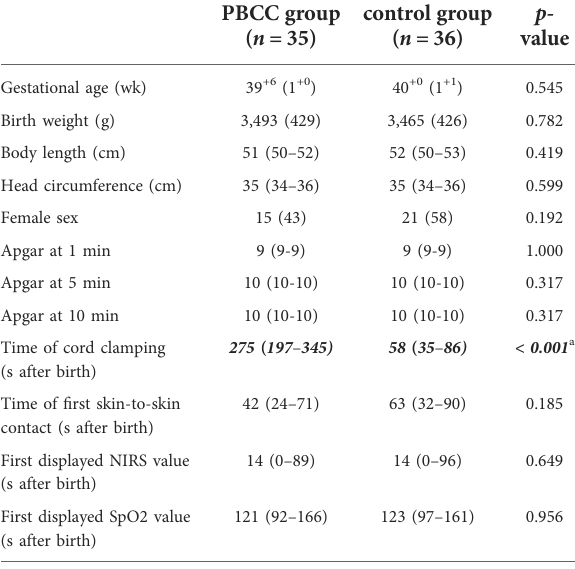
TABLE 1 Demographic and clinical characteristics of PBCC and control group. Data are presented as n (%), mean (SD), or median